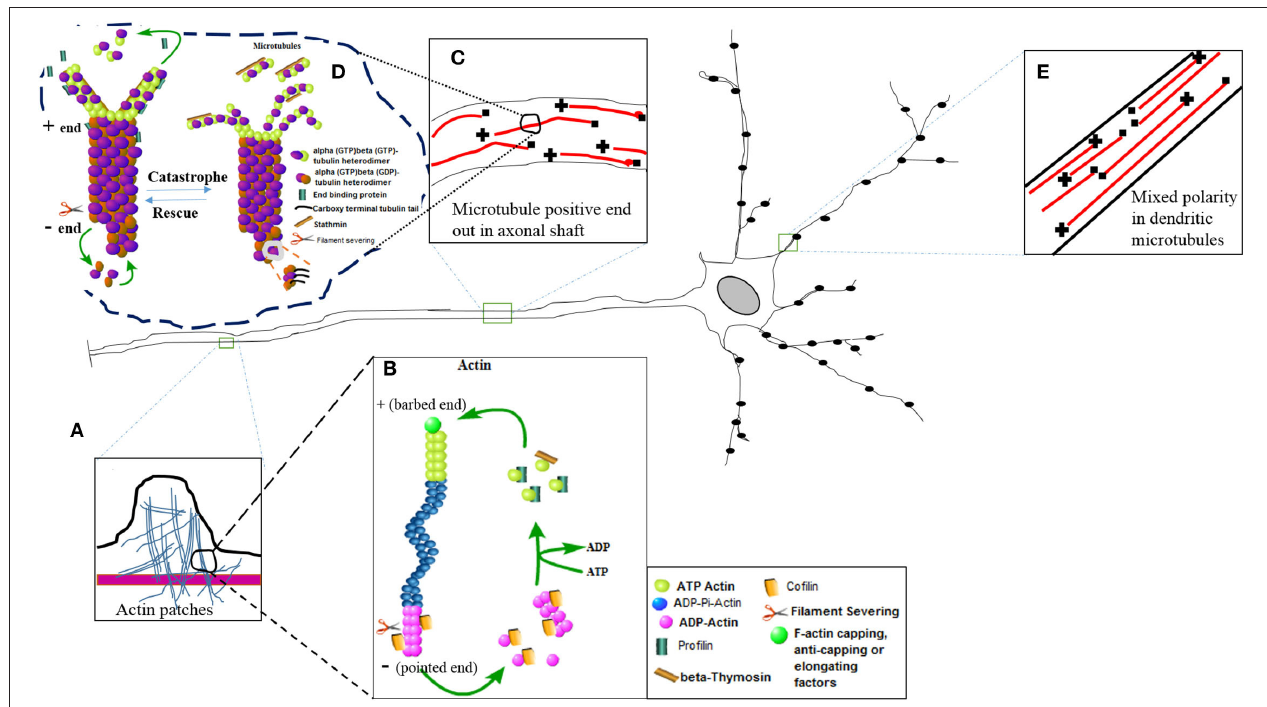
FIGURE 1 | The diagram of nerve cell showing different inset images of the active nature of the actin and microtubule cytoskeleton. (E) Mixed polarity of the microtubules exists in the dendrites of the neurons. (C) Positive ends are laid down in the axonal shaft for efficient bidirectional axonal transport. (A) The actin patches have been magnified in the inset image to show their presence in the axonal shaft. These actin patches act as a source to create further branches arising at different lengths of the axon. Further magnification of actin and microtubule images represent molecular structures showing the active phenomena of actin polymerization (B) and microtubule polymerization (D) or nucleation with the help of different binding proteins.